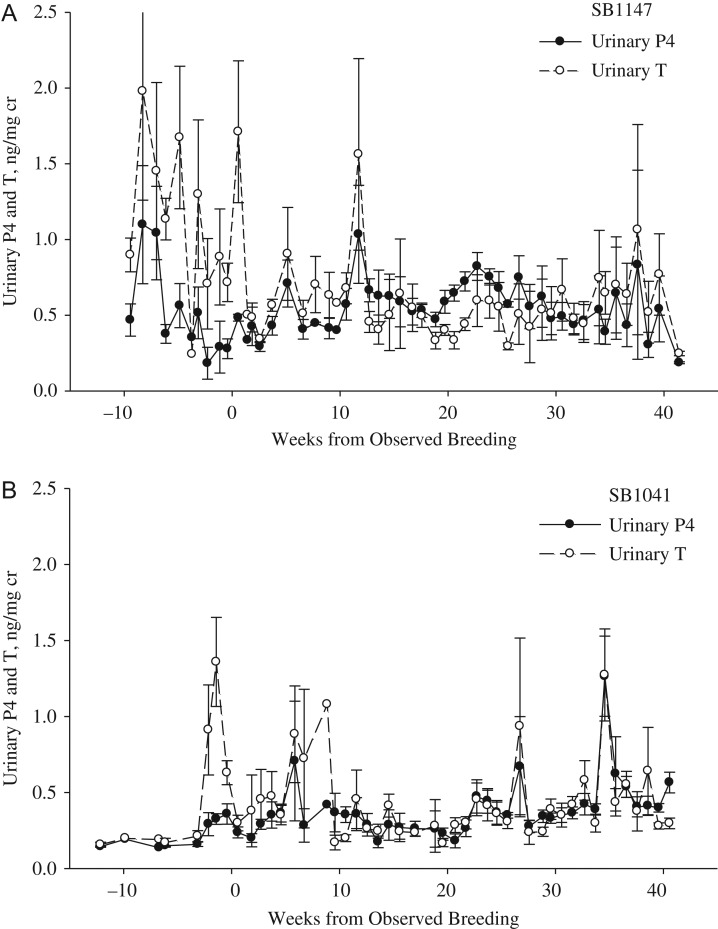
Weekly progestin (P4) and androgen (T) concentrations (mean ± SEM) in urine from captive female polar bears during presumed ovulatory-non-parturient cycles as aligned to the last day of observed breeding (n = 2 reproductive cycles for each female). (A) The cycles for SB1147, 2013–14 and (B) the cylces for SB1041, 2011–12.